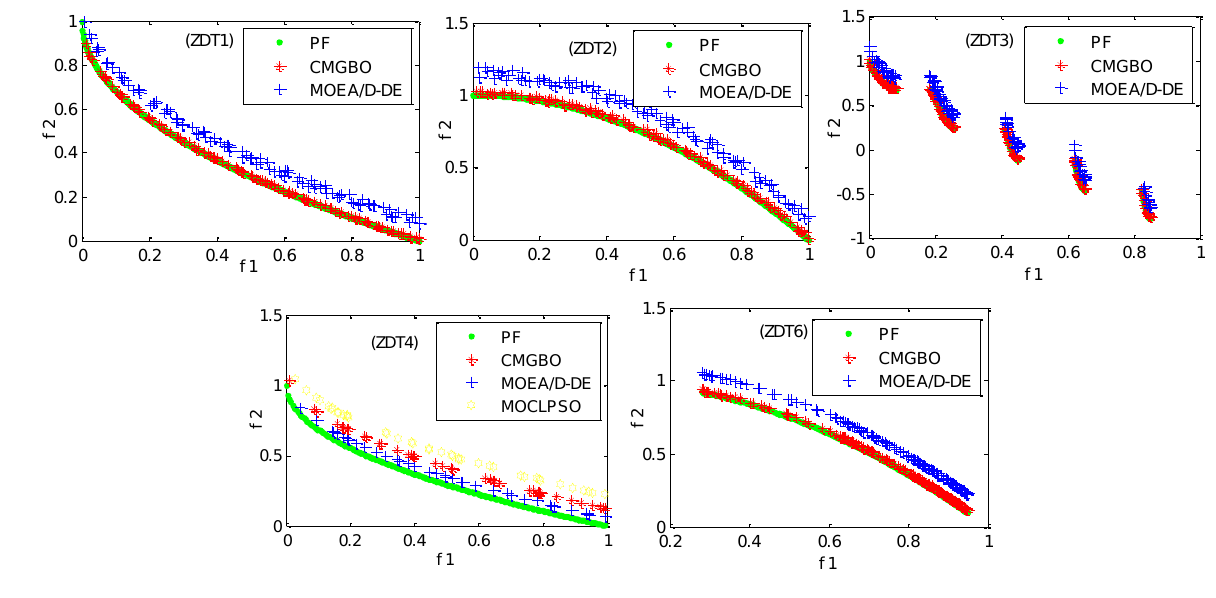
Figure 3. Non-dominated solutions of ZDT problems. Figure 3. Non − dominated solutions of ZDT problems.